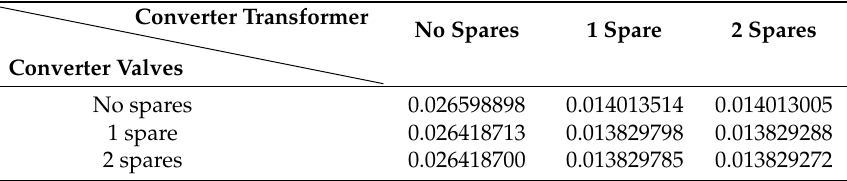
Table 8. Energy unavailability in different redundant structure configuration.